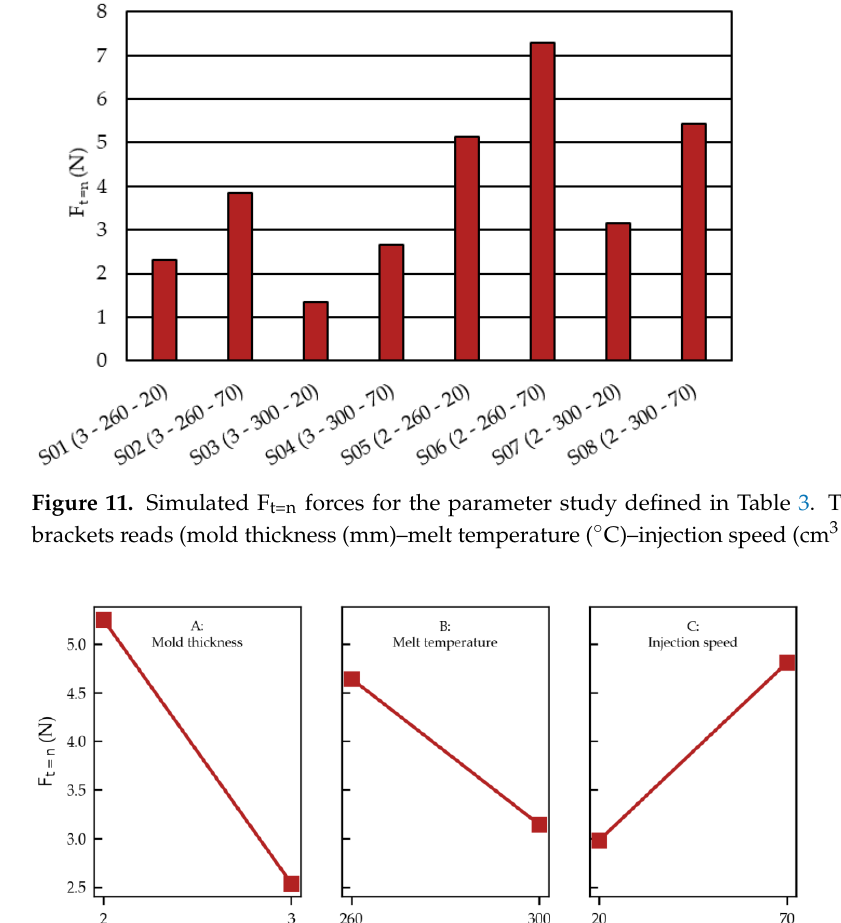
(A), the higher the melt temperature (B), and the slower the injection speed (C).